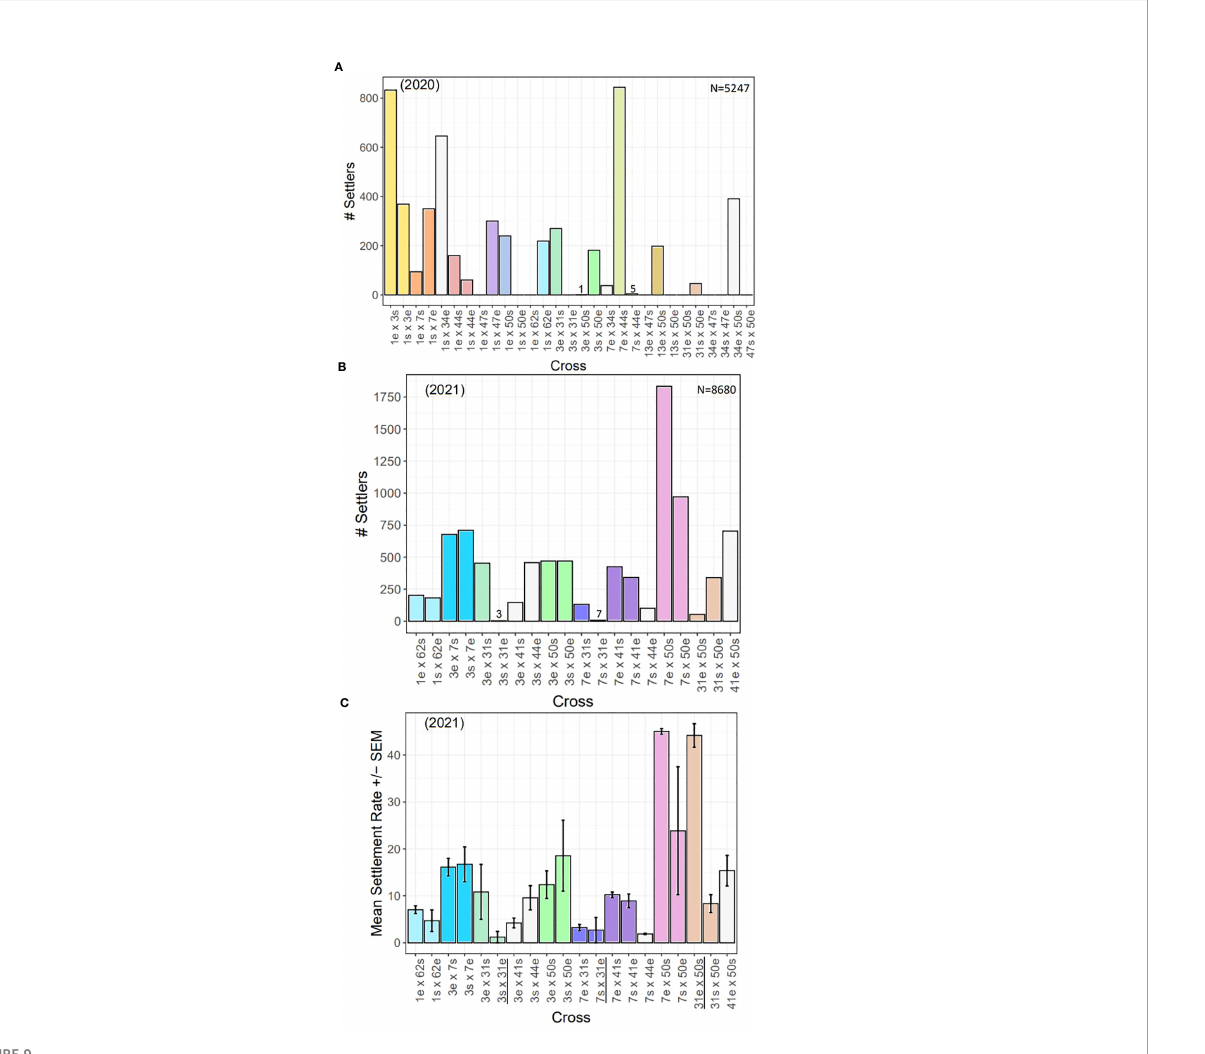
FIGURE 9 Settlement by year and cross. (A) Total number of settlers for each cross conducted in 2020 (N=5247 settlers). (B) Total number of settlers for each cross conducted in 2021 (N=8680 settlers). (C) Mean settlement rates (± SEM) for each cross in 2021. There were signi fi cant differences in settlement rates across families (statistics in text). All settlement assays had the same larval stocking density, except those with 31e (black underlined, see Methods & Results), so they cannot be directly compared. In all plots, direct and reciprocal crosses are paired by color, uni- directional crosses are white, and the 2020 crosses repeated in 2021 have the same color